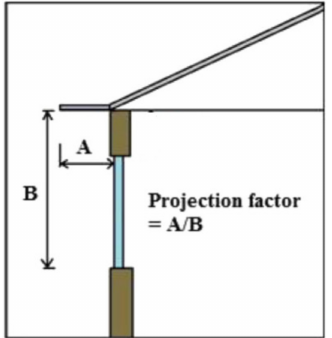
Figure 5. Overhang projection